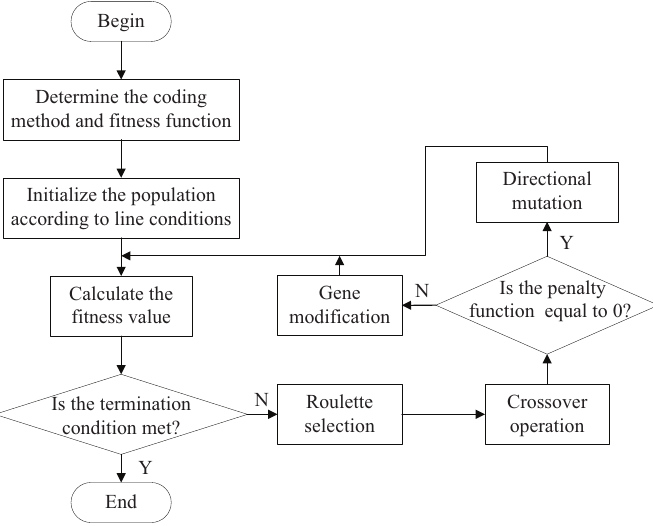
Figure 10. The flow chart of improved genetic algorithm